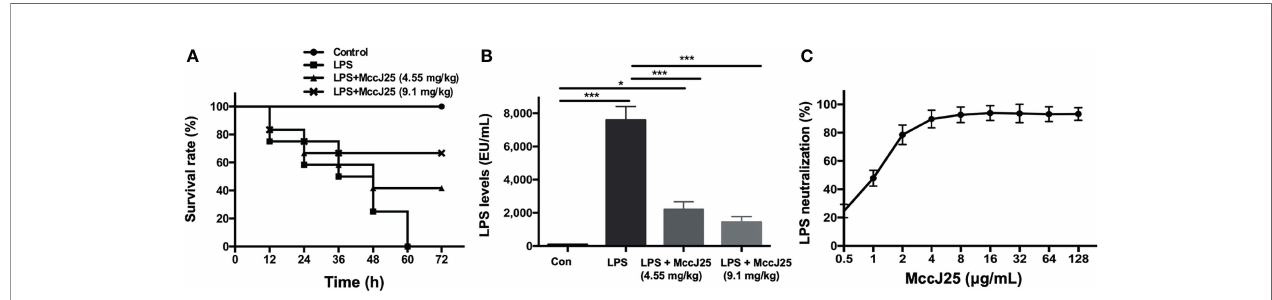
FIGURE 6 | MccJ25 inhibited the LPS-induced decrease in the survival rate. (A) Addition of the AMP MccJ25 increased the probability of survival in mice with septic shock induced by E coli O111:B4 LPS (15 mg/kg/BW). (B) The LPS concentration in the mice plasma. (C) In vitro E coli O111:B4 LPS neutralization by the antimicrobial peptide MccJ25. Data are indicated as the means ± standard error of mean from 6 biological replicates. * P < 0.05, *** P